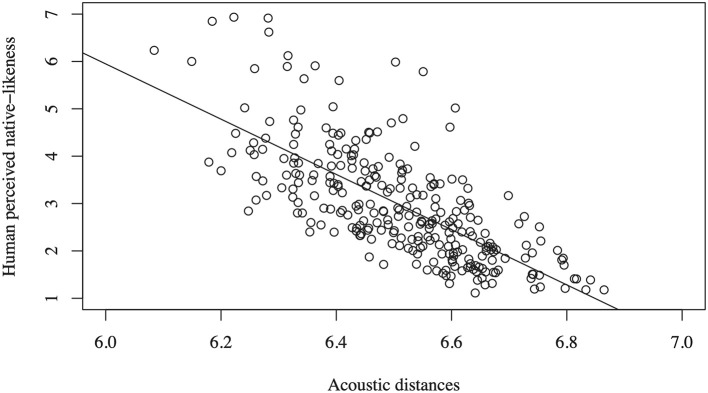
Native-likeness ratings as a function of the computed acoustic distances (r = −0.71).